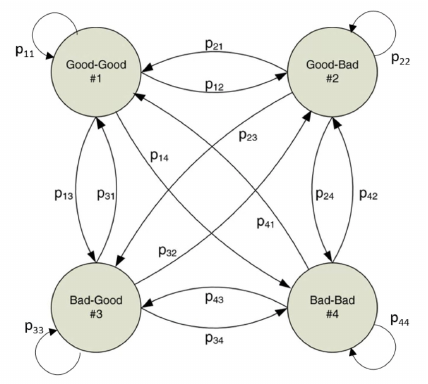
Figure 5. Four-state Markov channel